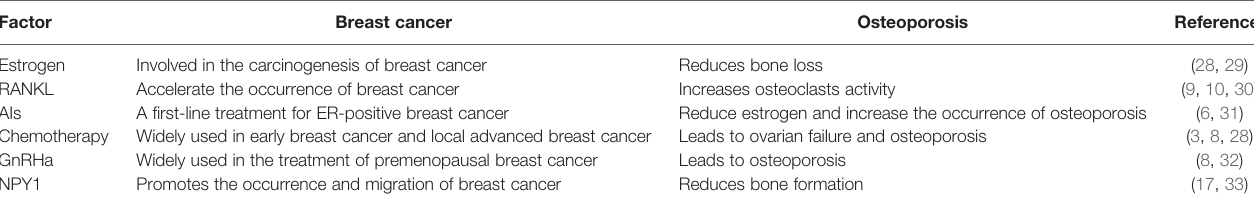
TABLE 1 | Links between breast cancer and osteoporosis. Factor Breast